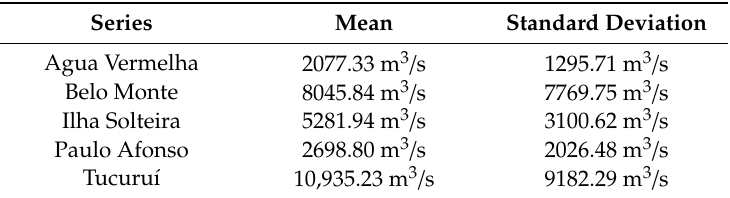
Table 1. Mean and standard deviation of the sets.